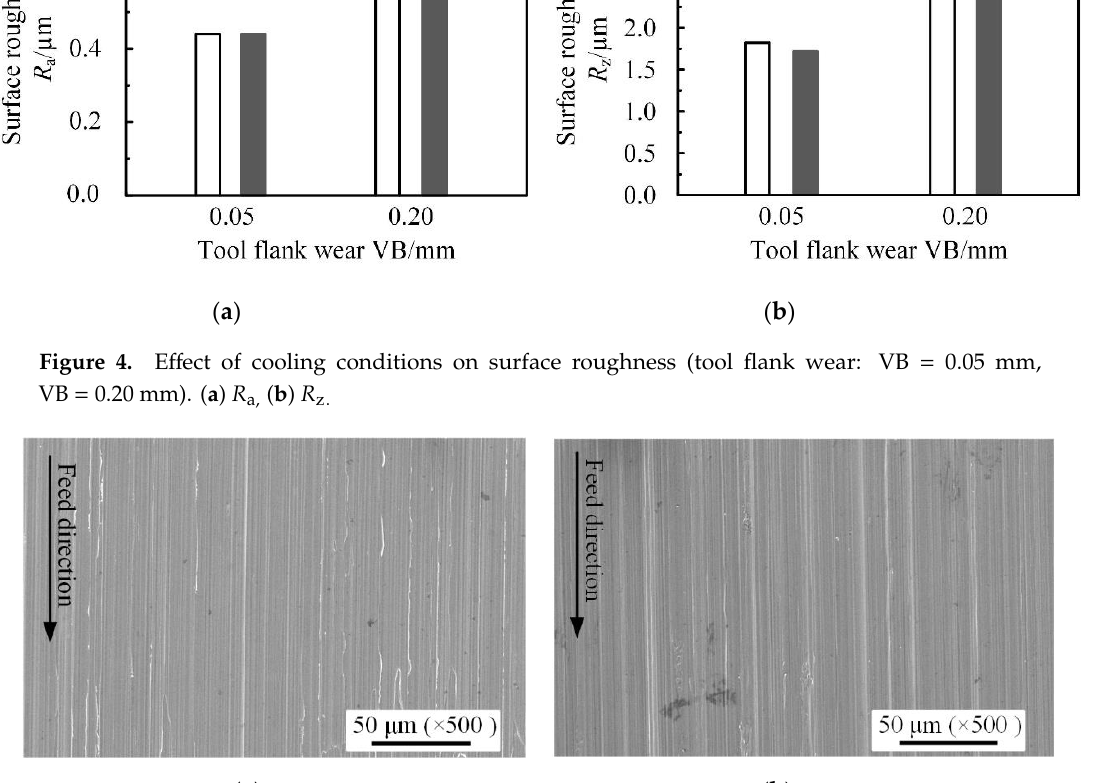
Figure 4. Effect of cooling conditions on surface roughness (tool flank wear: VB = 0.05 mm, VB = 0.20 mm). ( a ) R a, ( b ) R z.